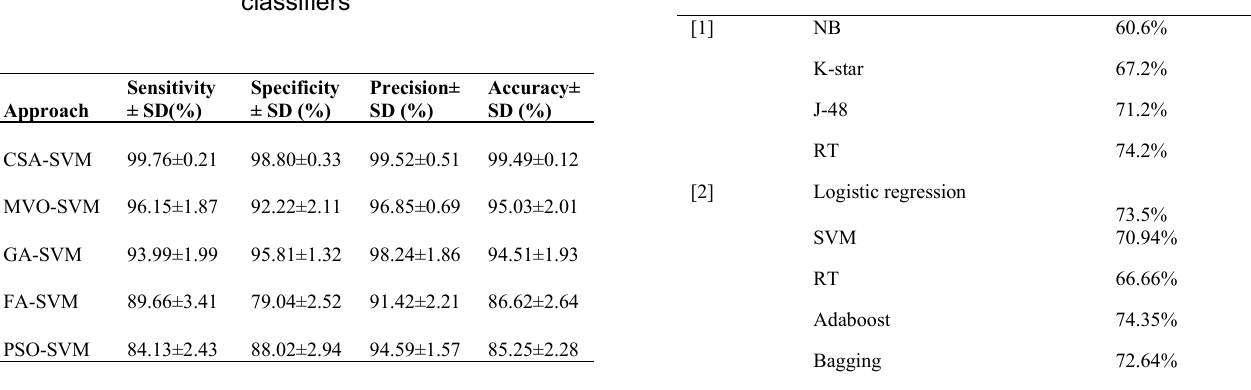
Table 4. Performance comparison of SVM